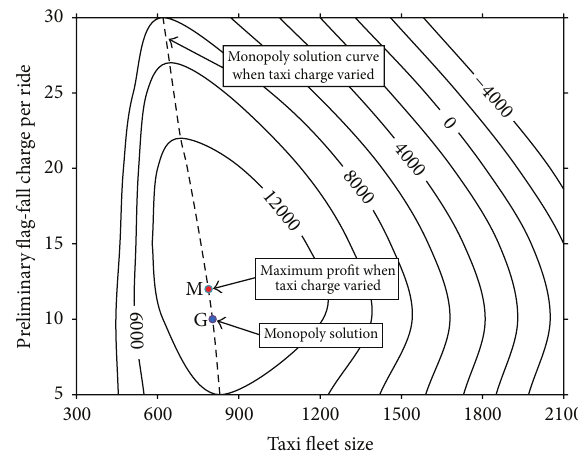
Figure 2: The profit of taxi firm for monopoly market as taxi fleet size and fare varied.